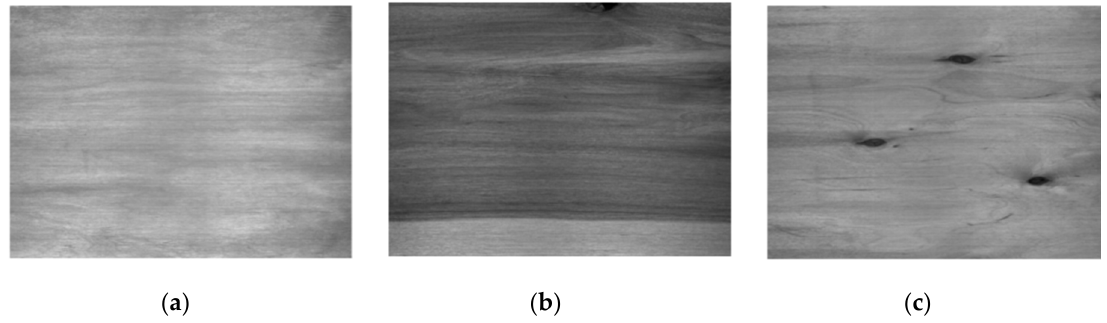
Figure 3. Samples of veneers: ( a ) nondefective; ( b ) with visible core; ( c ) with visible branches.